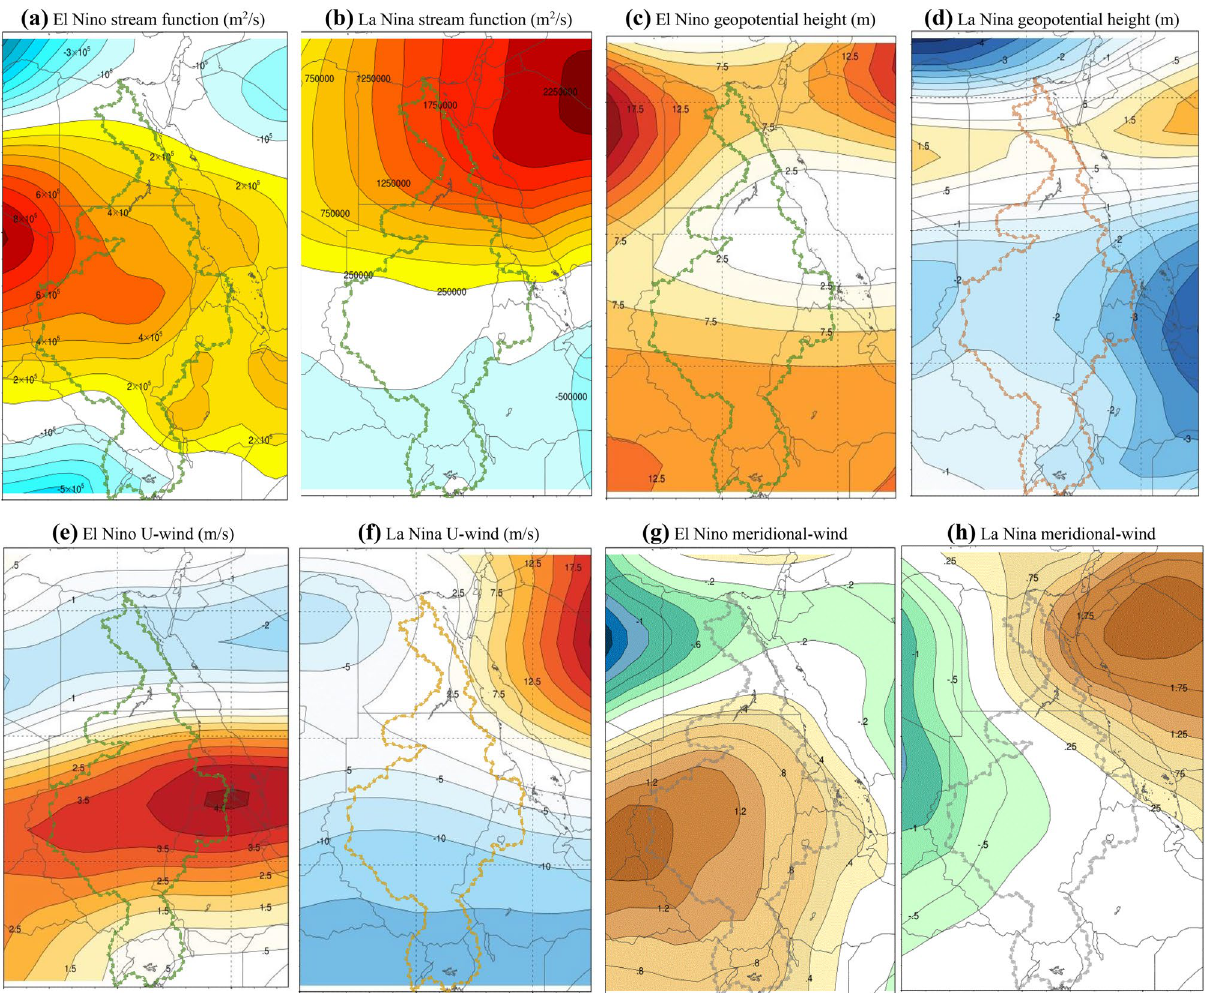
Figure 11. The effect of ENSO to the atmospheric circulation over NRB shown by the 750-mb stream function anomaly associated with El Nino ( a ) and La Nina ( b ) episodes (shaded contours, red/brown for positive and blue for negative anomalies), 300-mb geopotential height anomaly associated with El Nino ( c ) and La Nina ( d ) episodes, zonal and meridional wind anomaly patterns associated with El Nino ( e , g ) and La Nina ( f , h ) episodes, respectively. The signals between ENSO and GPH, stream functions, and meridional/zonal wind in the troposphere demonstrates the teleconnection between El Niño and the atmospheric circulation over of NRB. The warming over WIO and stronger El Niño, the southward shift of the lower atmospheric stream functions and meridional winds, and the westward shift of zonal winds have together contributed to worsening droughts observed in NRB in recent years. The maps were generated with NCAR Command Language (NCL) Version 6.2.1 (http:// www. ncl. ucar.